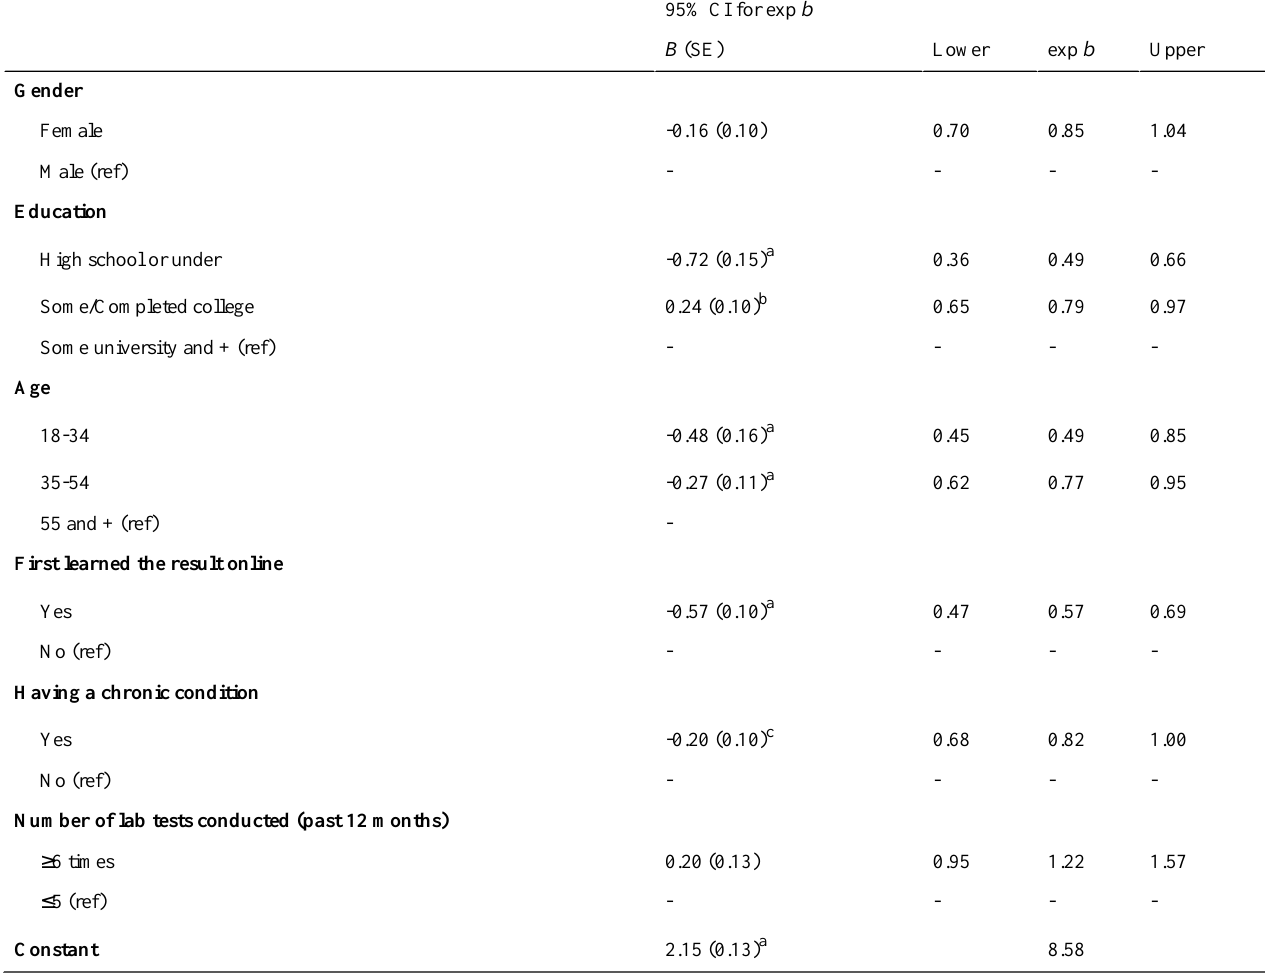
Table 4. Very confident in fully understanding lab results (logistic regression; n=2796; 194 cases were excluded from analysis; % correct predicted values: